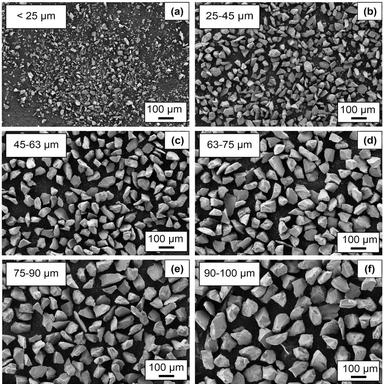
SEM images of the different sieved fractions (a-f).